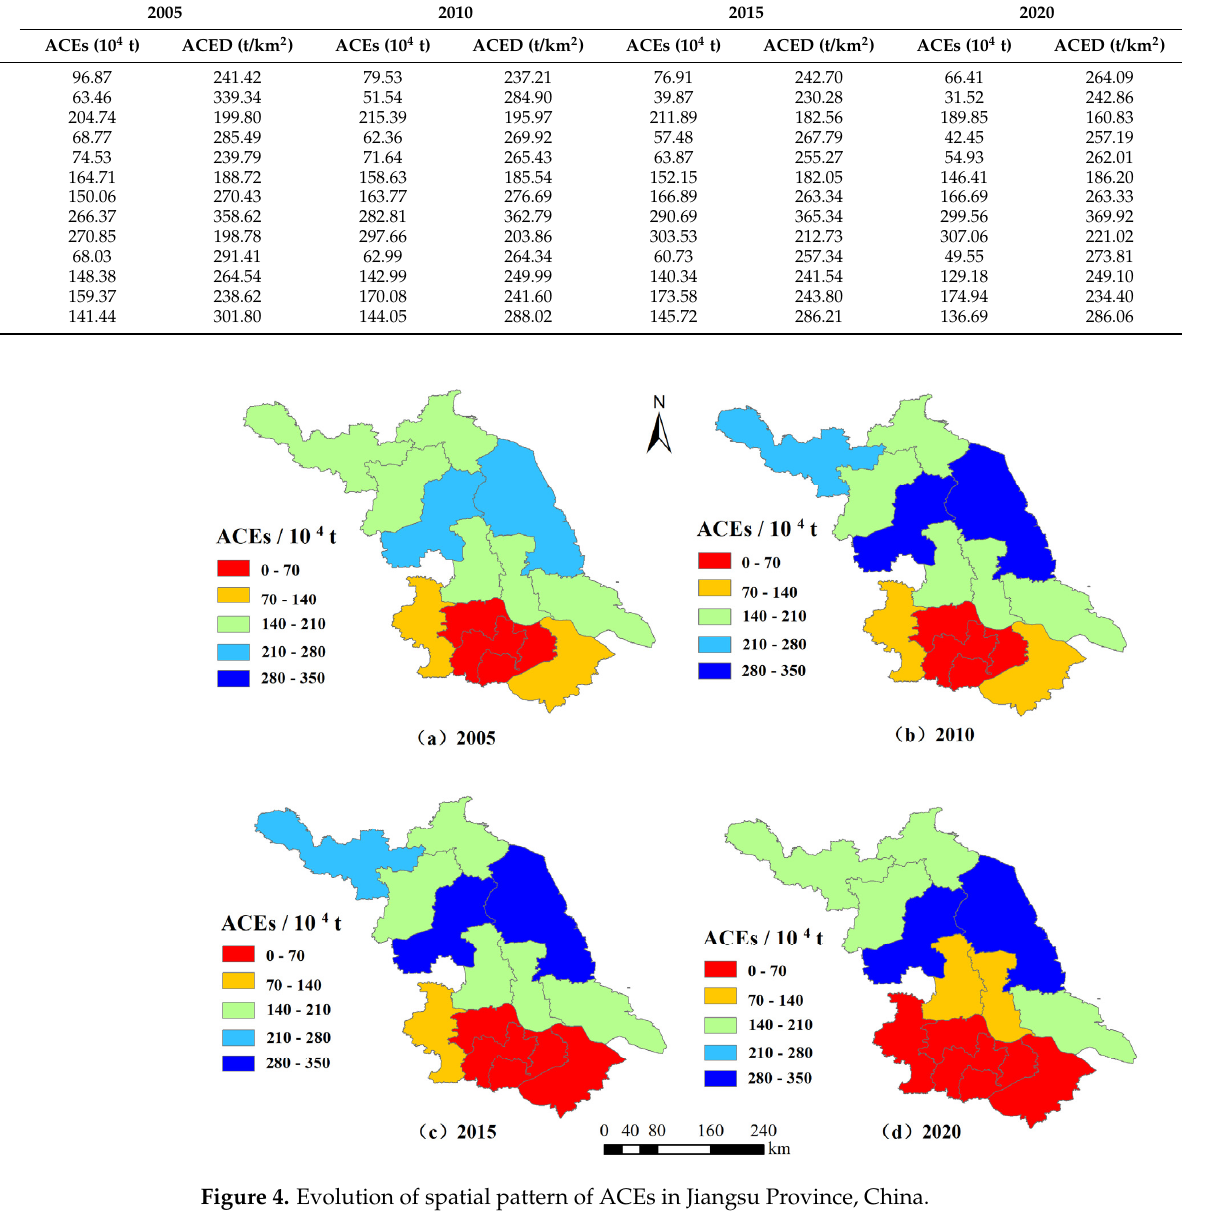
Table 4. Changes in ACEs and ACED in Main Years.